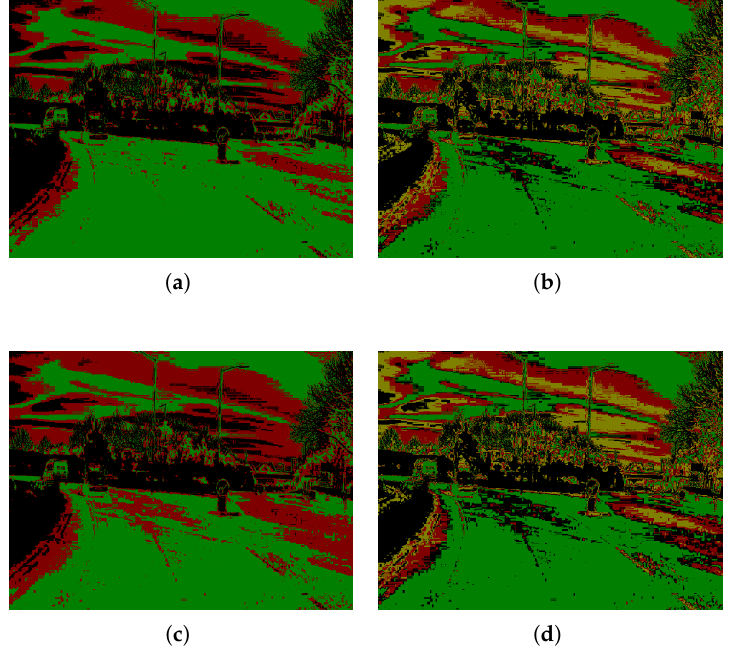
Figure 6. CamVid segmented images for different block sizes. ( a ) Block size 4 × 8. ( b ) Block size 4 × 16. ( c ) Block size 8 × 8. ( d ) Block size 8 × 16.